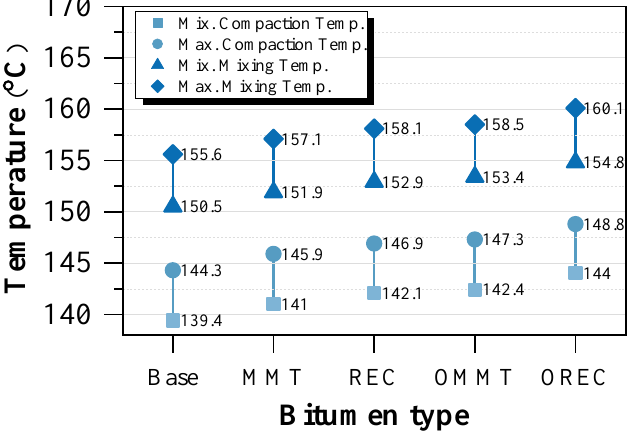
Figure 5. The construction temperature of the bitumen specimens.